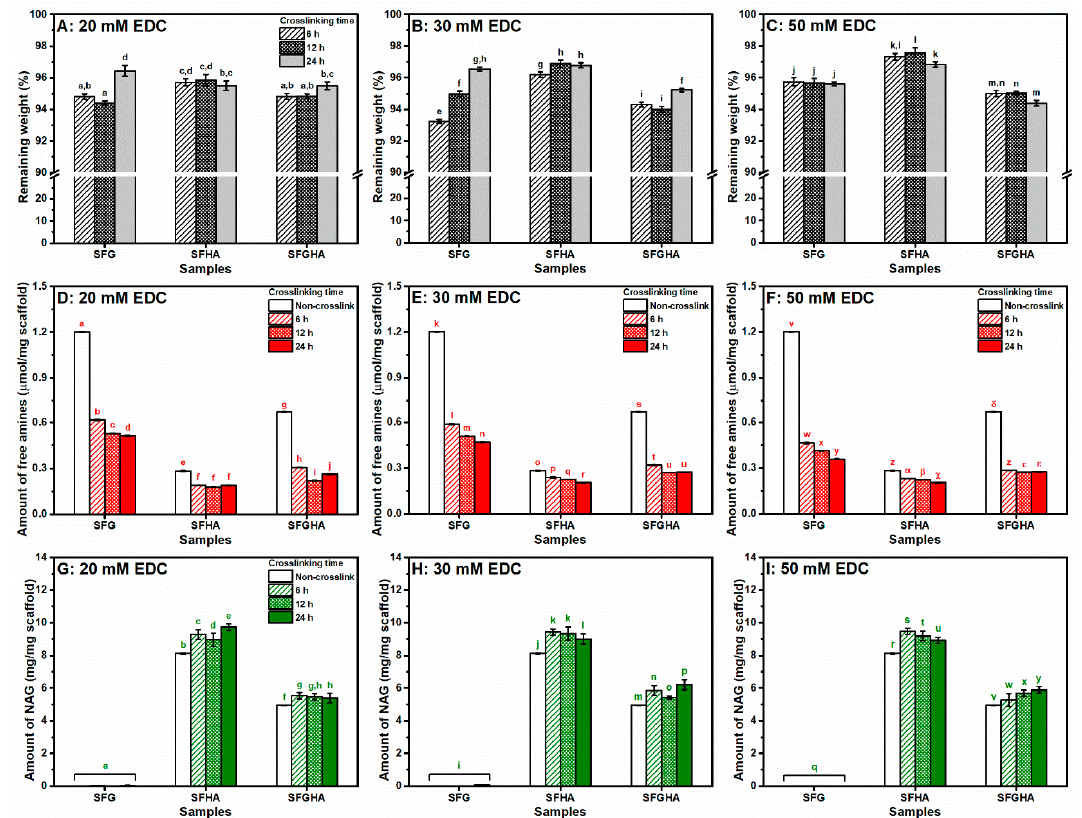
Figure 1. Crosslinking efficiency of the scaffolds at different EDC concentrations (20, 30, and 50 mM) and crosslinking times (6, 12, 24 h). ( A – C ) The remaining weight (%) of the scaffolds, ( D – F ) the amount of free amine groups of non-crosslinked and crosslinked scaffolds analyzed by TNBS assay, and ( G – I ) the amount of NAG groups determined by Elson–Morgan assay. The alphabetical letters annotate the statistical difference at a p -value ≤ 0.05. The statistical analysis was performed within the same concentration of EDC used in the crosslinking reaction.